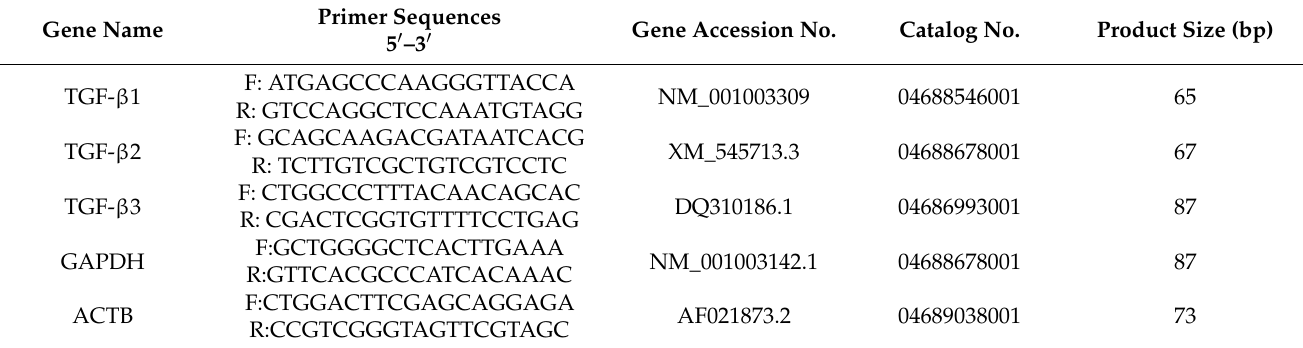
Table 2. Oligonucleotide sequences and probe number use for real-time